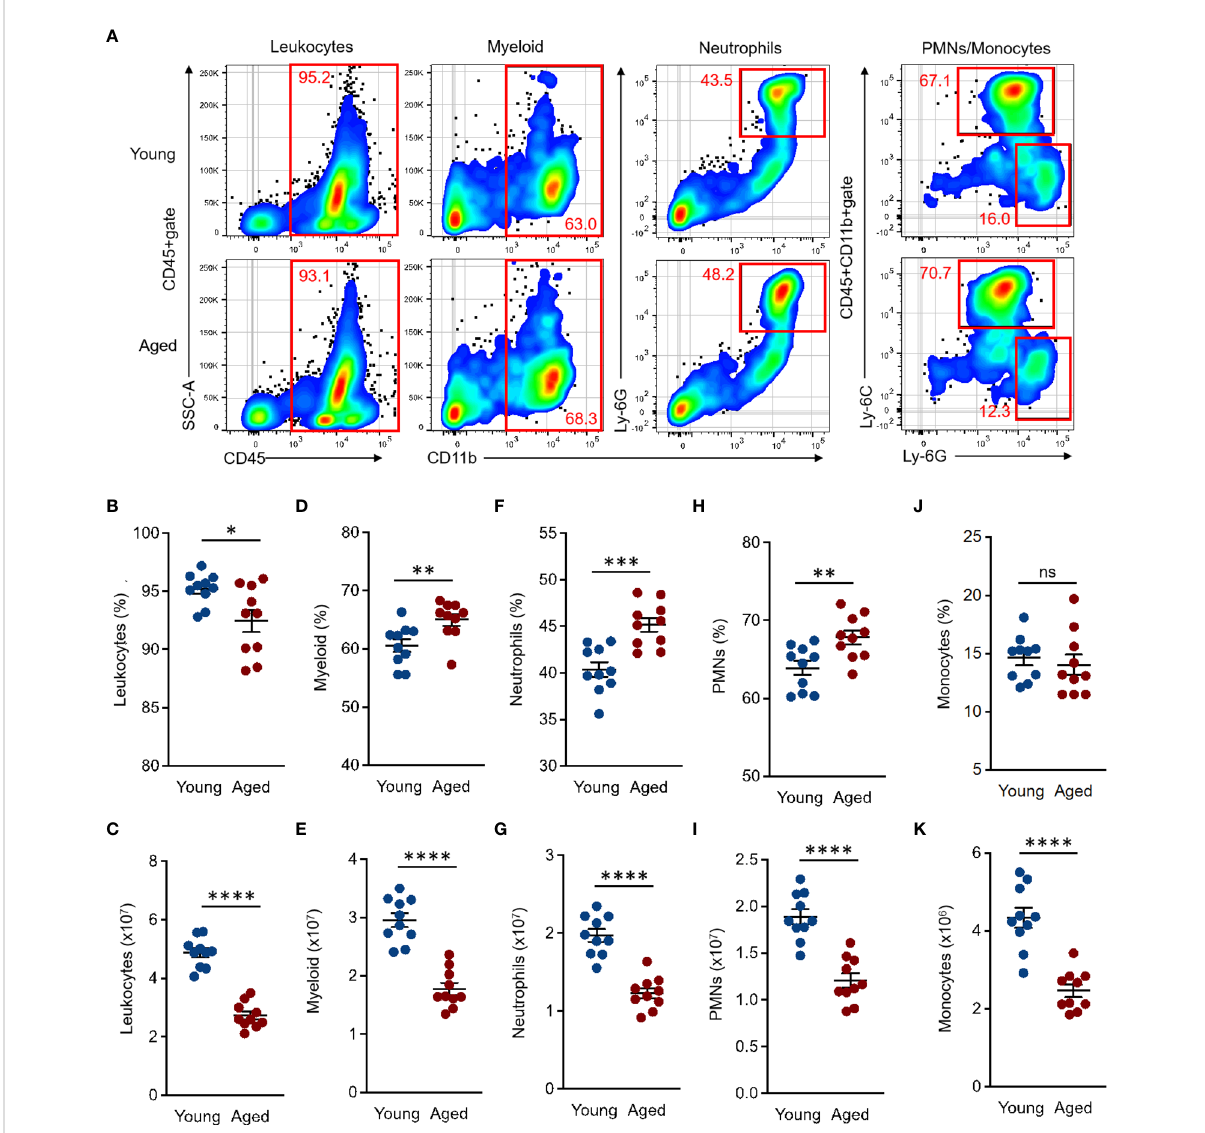
FIGURE 1 Comparison of myeloid lineage cells in BM of young and aged mice BM cells were isolated from the tibia and femur of both young (10 to 20 weeks) and aged (20 to 22 months) mice for fl ow cytometry analysis. Flow cytometry analysis was performed by following the gating strategy represented in Supplemental Figure 2. (A) Representative plots of total leukocytes, myeloid, granulocytes, PMNs, and monocytes in fl ow cytometry analysis. (B, C) Percentage (B) and number (C) of total leukocytes (CD45+). (D, E) Percentage (D) and number (E) of total myeloid (CD11b+ in CD45+gate). (F, G) Percentage (F) and number (G) of granulocytes (CD11b+Ly-6G+ in CD45+gate). (H, I) Percentage (H) and number (I) of PMNs (Ly-6G+Ly-6Cdim/+ in CD45+CD11b+gate). (J – K) Percentage (J) and number (K) of monocytes (Ly-6G-Ly-6Chi in CD45 +CD11b+gate). The number of cells in the populations were calculated as per mouse (BM). The cumulative data are shown as mean ± SEM values of 10 samples. Student ’ s t -test was used to analyze data for signi fi cant differences. Asterisks indicate signi fi cance: * p < 0.05, ** p < 0.01, *** p < 0.001, and **** p < 0.0001. ns; not signi fi